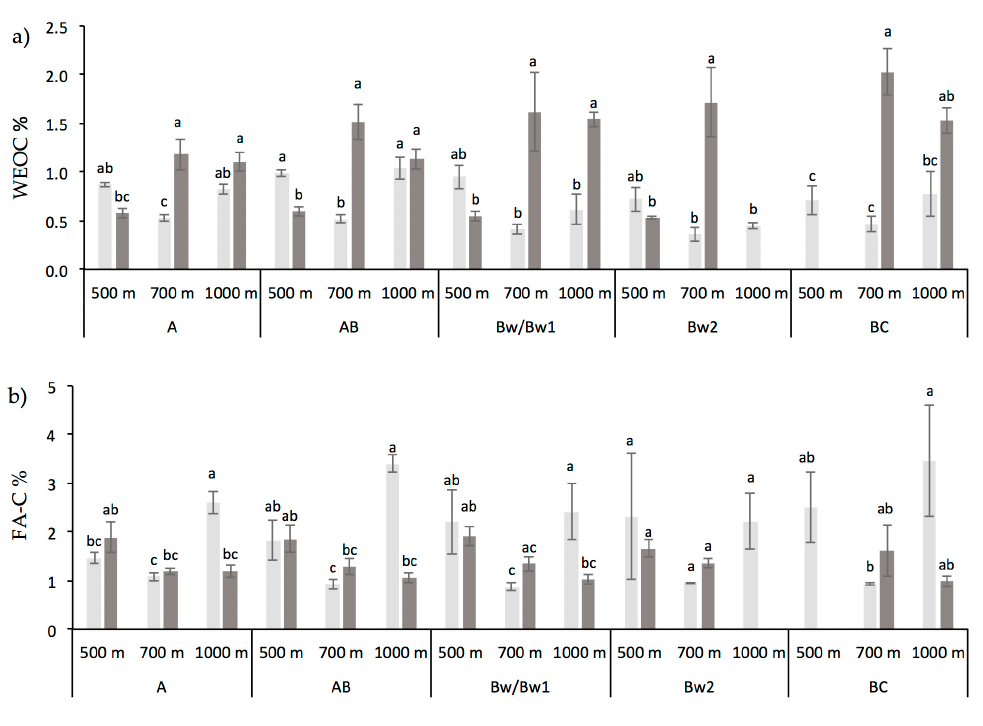
Figure 2. Percentage distribution of the soil organic carbon as (a) water-extractable organic carbon 231 (WEOC), (b) fulvic acid carbon (FA-C), (c) humic acid carbon (HA-C) and (d) non-extractable organic 232 carbon (NEOC) for the soils under broadleaf (light bars) and pine (dark bars) forests at 500, 700 and 233